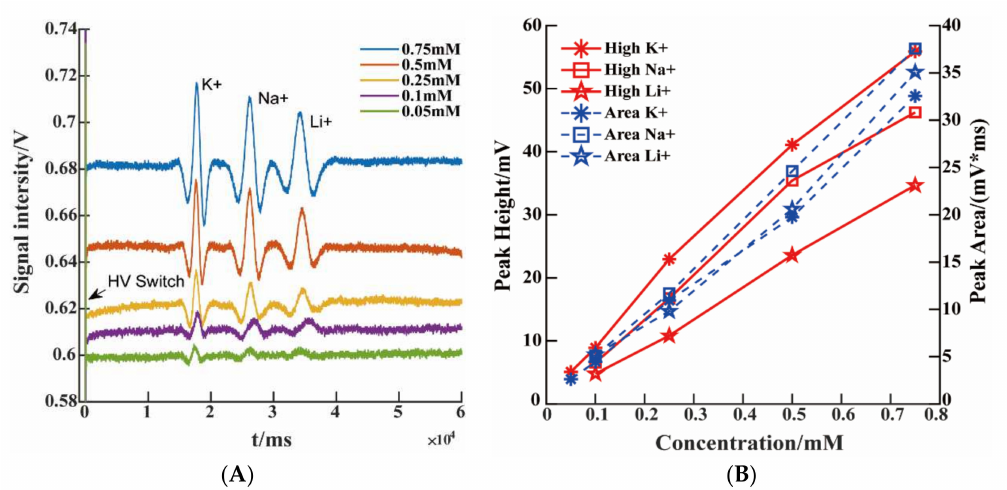
Figure 5. ( A ) An electropherogram of five concentrations. ( B ) Calibration curves of peak height sensi- tivity and peak area sensitivity of microchip electrophoresis with PG-C4D. Operational conditions were the same as in Figure